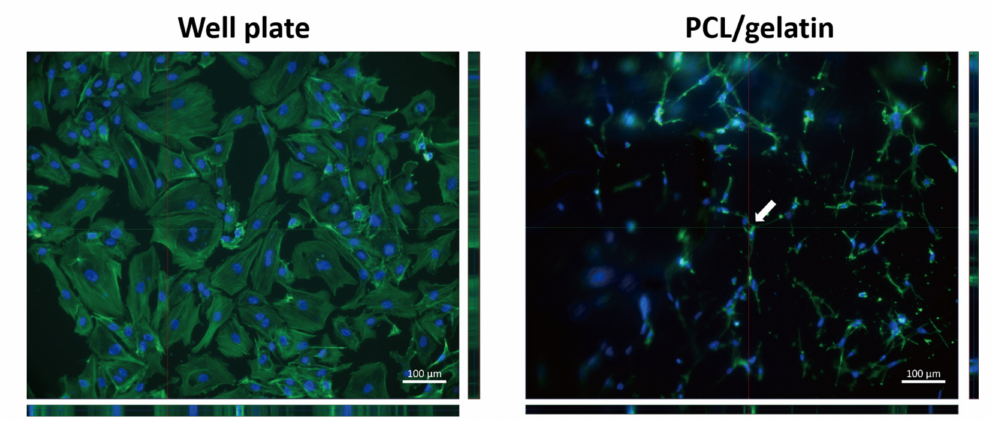
Figure 6. Lumen formation of monocultured HUVECs in the 24-well plate and the PCL/gelatin nanofiber scaffolds after seven days culture. The white arrow indicates the luminal structure of HUVECs. Scale bars represent 100 µ